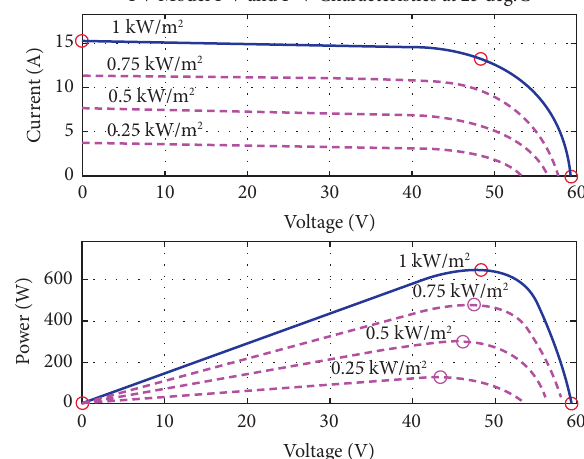
Figure 1: Block diagram of the system. Table 1: PV system specifcations. PV Model I-V and P-V Characteristics at 25 deg.C